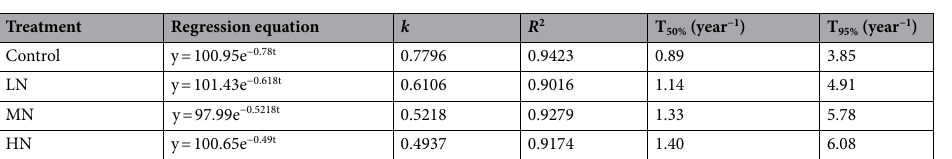
Table 2. Decomposition rate constant ( k ), coefficients of determination ( R 2 ), and time to 50% (T 50% ) and 95% (T 95% ) decomposition of leaf litter under different nitrogen deposition treatments. LN simulated low nitrogen deposition; MN simulated medium nitrogen deposition; and HN simulated high nitrogen deposition.